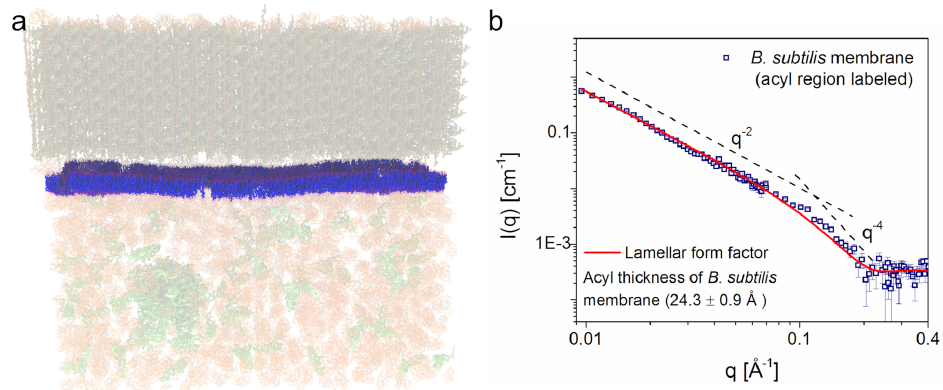
Figure 12. SANS with contrast matching applied to a living cell membrane [271]. ( a ) By feeding the cell deuterium-labeled fatty acids, it was possible to highlight the acyl core of the lipid bilayer. ( b ) The resulting SANS data could be fit for the thickness of the acyl chain region of the cell